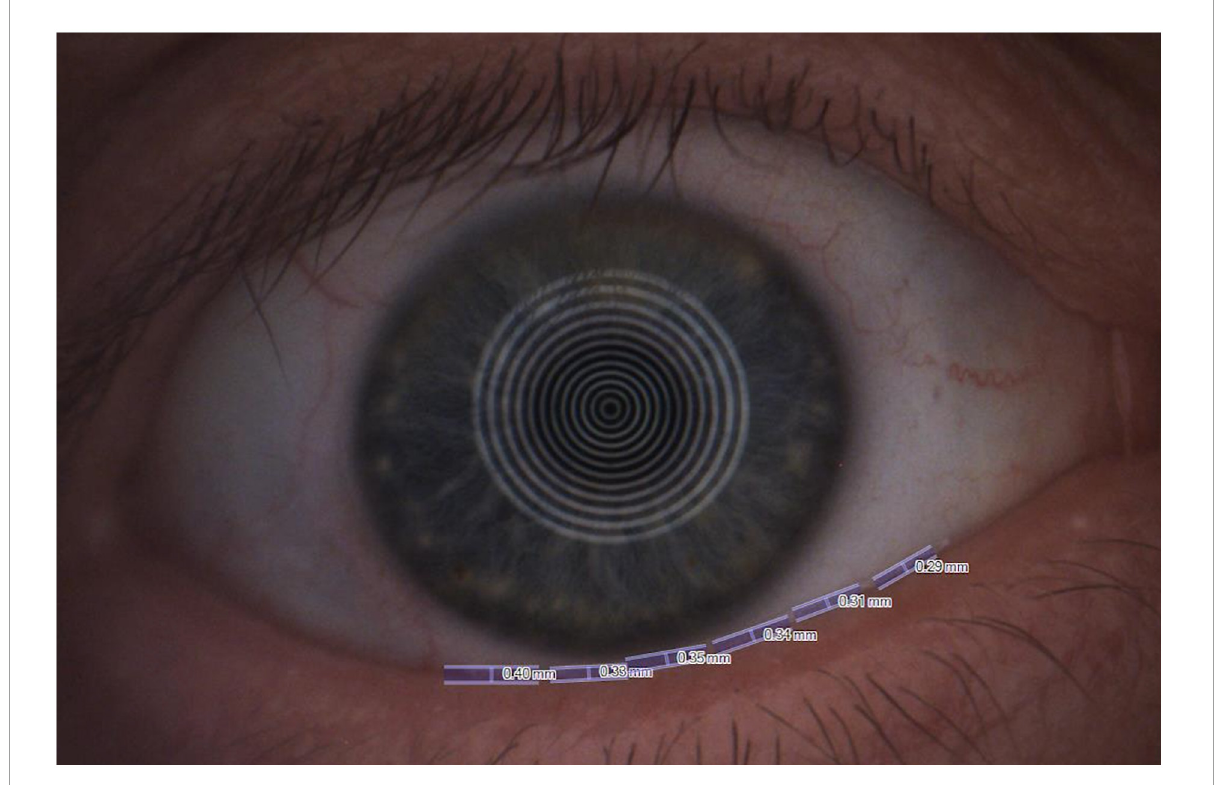
FIGURE2 The non-invasive tear meniscus height (TMH) measured with the Keratograph 5M software.